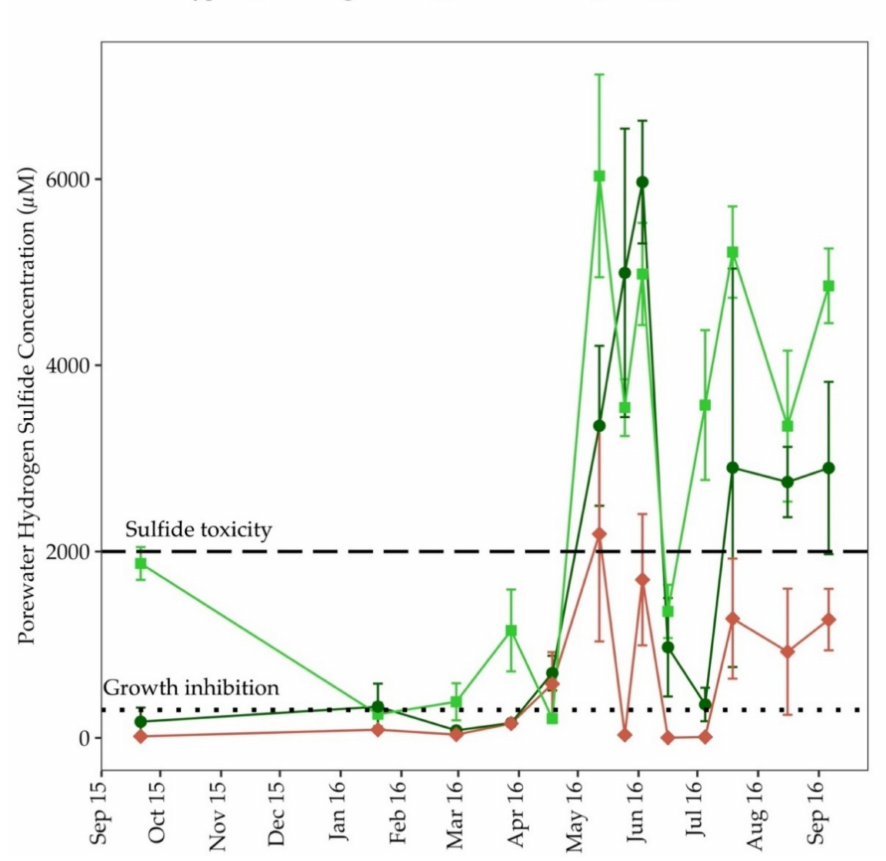
Figure 5. Porewater hydrogen sulfide concentrations in all substrate types from September 2015 to September 2016 at Big Sabine Point. Error bars represent the standard error of the mean. Growth inhibition begins at 300 µ M; sulfide toxicity is approximately equal to 2000 µ M